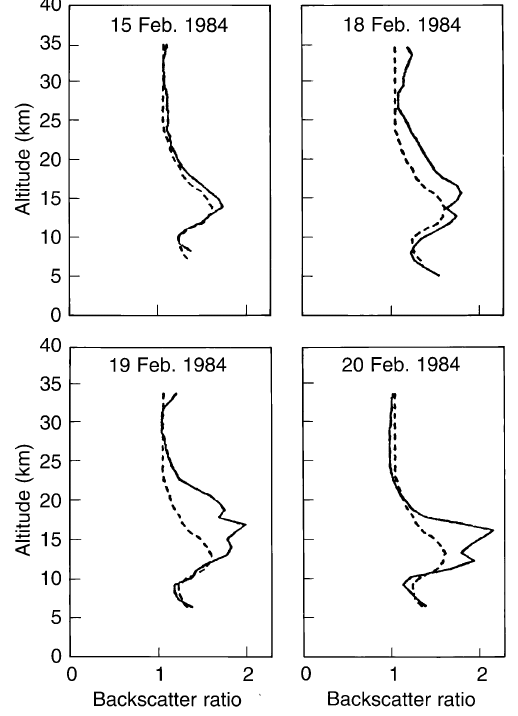
Fig. 2. The vertical profiles of scattering ratio R ( H ), l " 694.3 nm taken on 15, 18, 19, and 20 February 1984 at Verhnetulomski observatory. Dashed curves give the quiet day level averaged for previous five undisturbed days